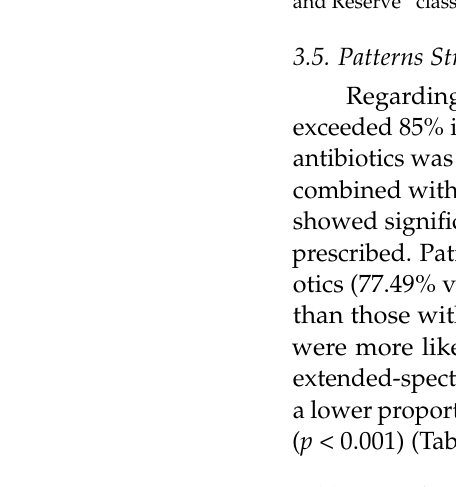
Table 5. Antibiotic prescription patterns stratified by chronic disease a